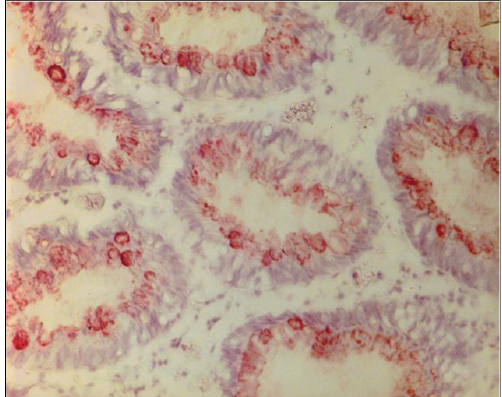
Figure 8. Photomicrograph ofAdnab-9 staining by immunohistochemistry in normal-appearing colonic mucosa. This photomicrograph with a particular magnification of 50×, in a normal colon biopsy section, showed the strong specific reddish-brown staining in the cytoplasm.